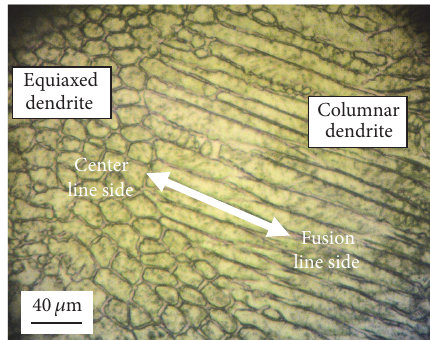
Figure 16: The change solidification mode by transition from fusion line to center